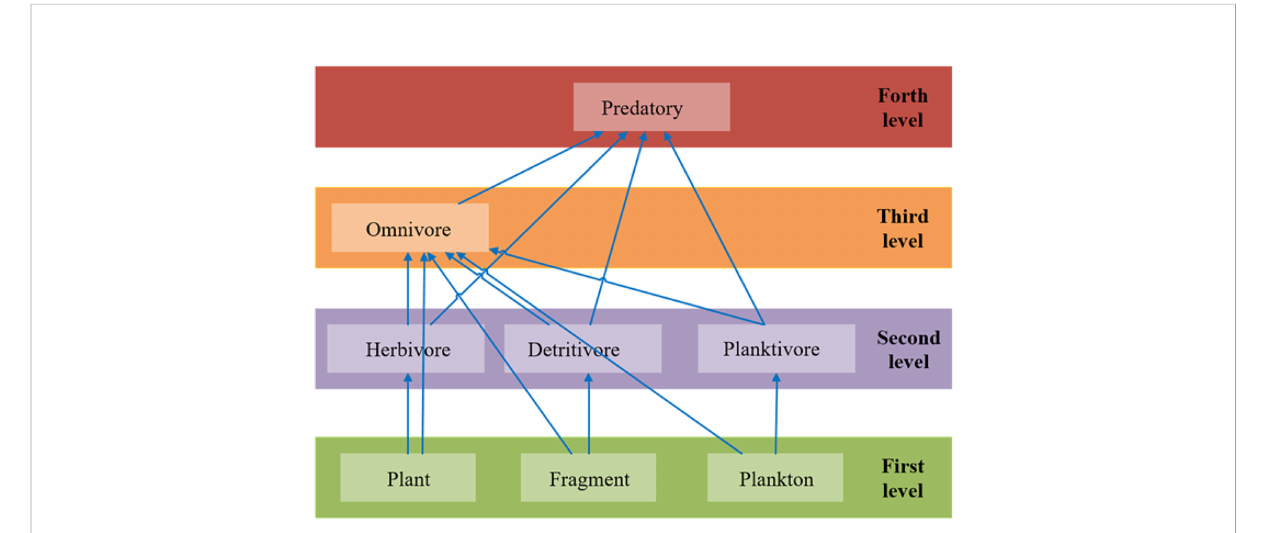
FIGURE 2 Trophic levels and food web of the microbenthic community, redrawn from Li et al.